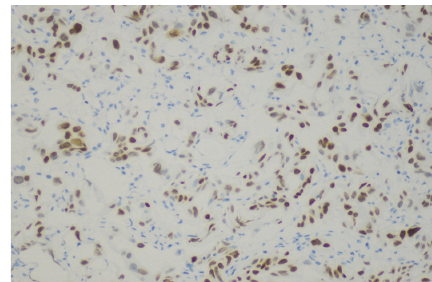
Figure 6: Bladder tumor with positive stain for CDX2.